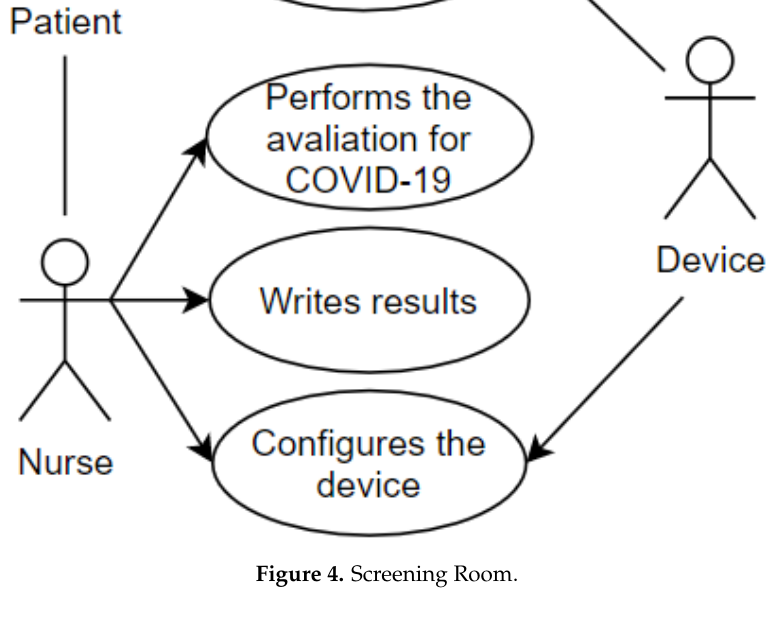
Figure 4. Screening Room.